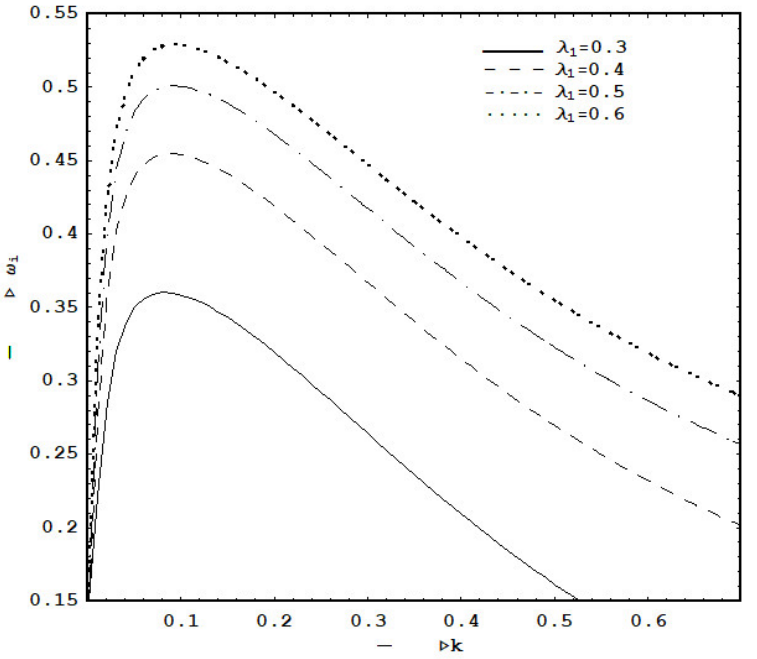
Figure 11. Variation of the growth rate ω i with the wavenumber k for different values of the permeability of the medium, λ 1